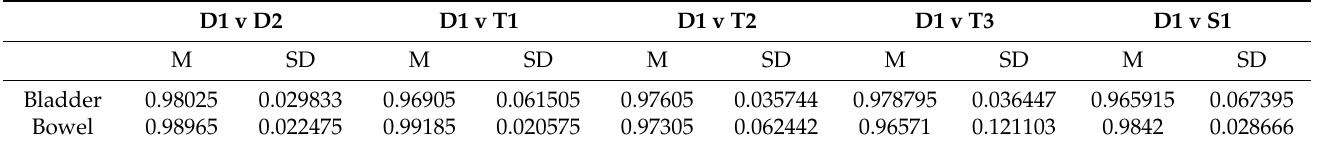
Table 3. Mean and standard deviation values for Dice similarity indices (DSI) for bladder and bowel structures for each pair-wise comparison of physician, therapist, and student. The comparison between physicians served as a benchmark to judge resulting outcomes.